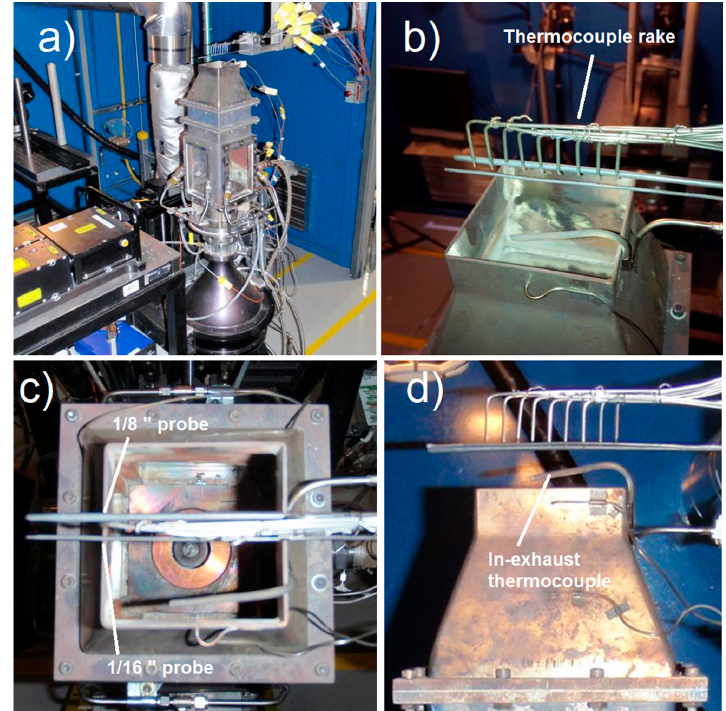
Figure 9. ( a ) Image of the gas turbine combustor simulator with ( b ) angled close up view of the exhaust region; ( c ) top view of the exhaust region and ( d ) side view of the exhaust region with thermocouples and FBG sensor probesdenoted in each figure.